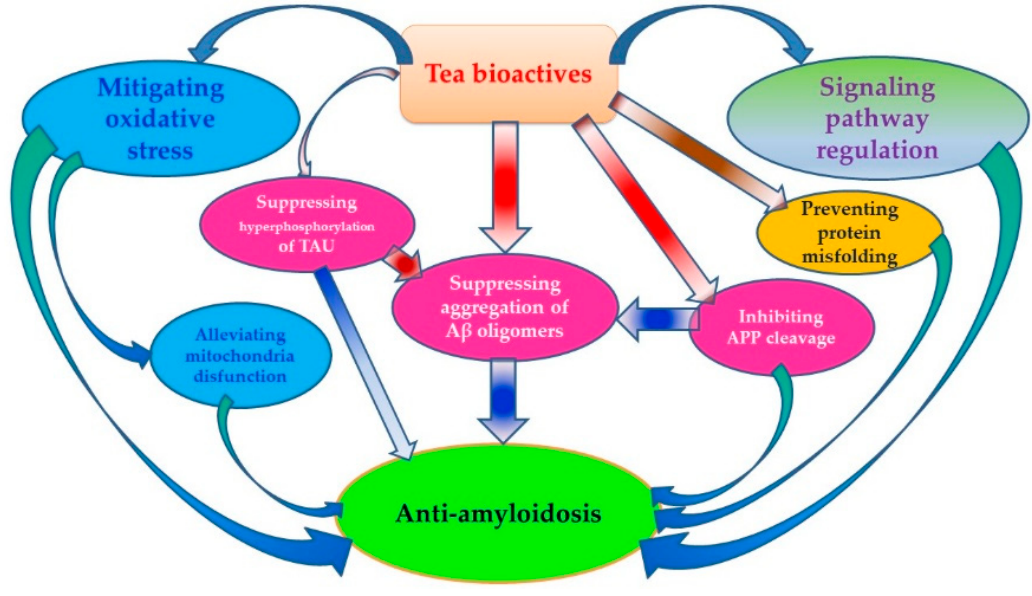
Figure 1. Anti-amyloidosis effects of tea.